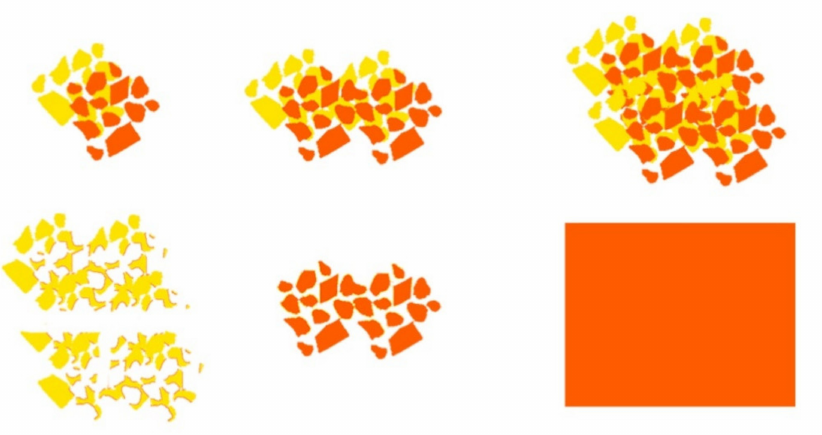
Figure 6. Assembly of different elements of the M03 module.